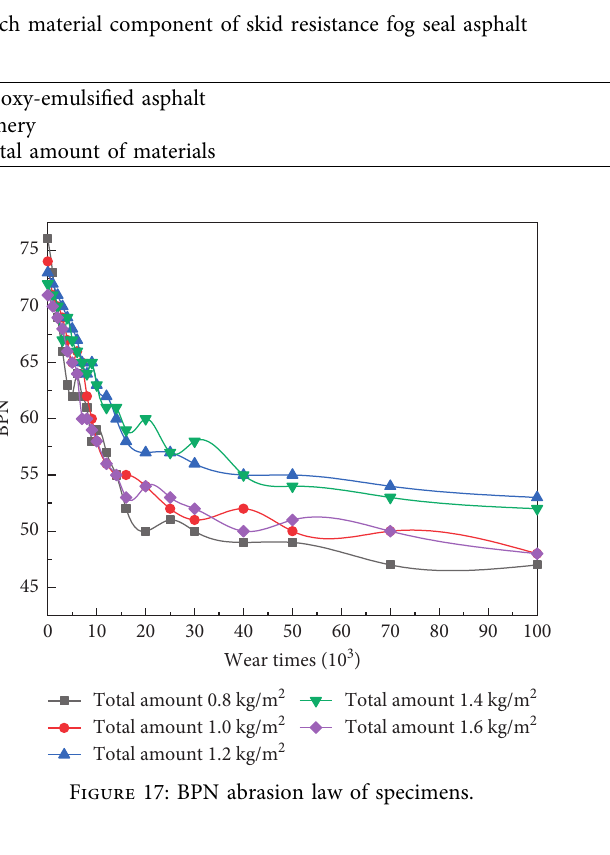
Table 12: The dosage and total dosage of each material component of skid resistance fog seal asphalt. The amount of each material component of the test specimen ( g ) Each material component of skid resistance fog seal asphalt